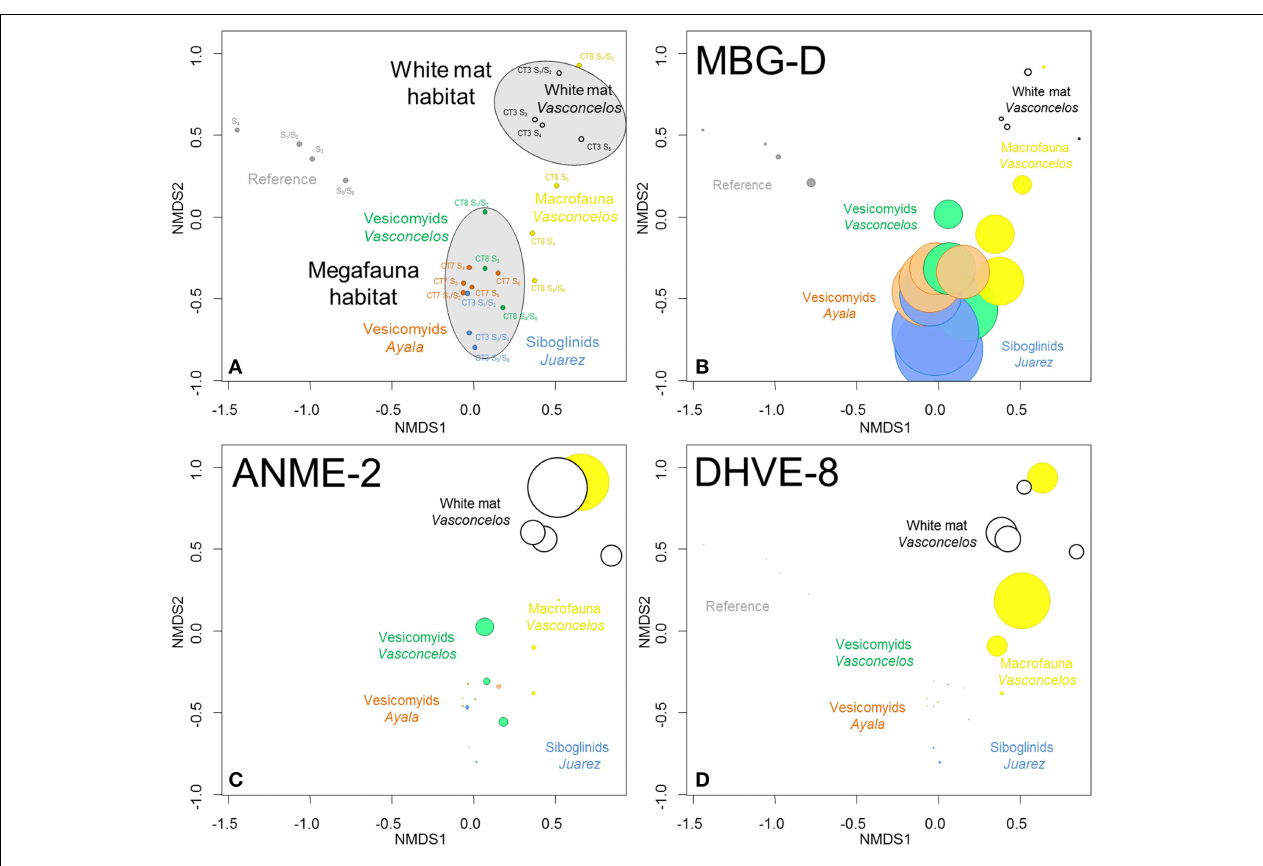
Vasconcelos BIG13—vesicomyids , yellow: Vasconcelos BIG18—macrofauna and black: Vasconcelos BIG18—white mat sites) indicates microbial